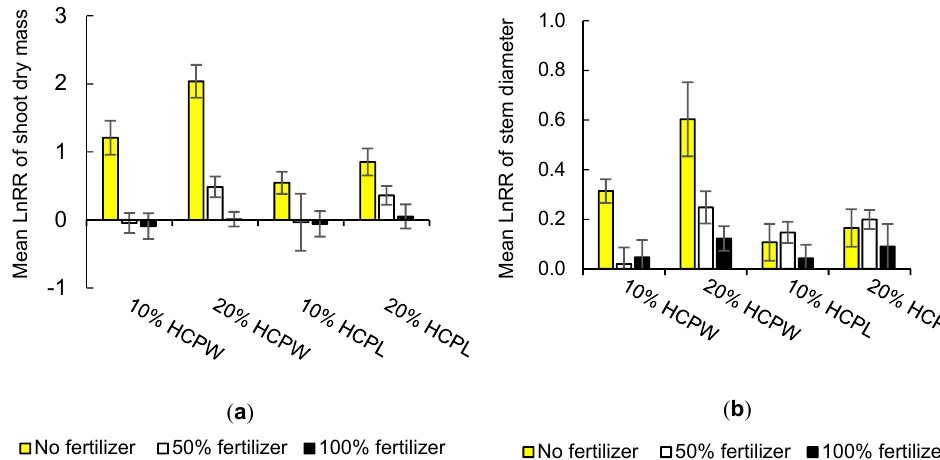
Figure 1. Mean (±95 CI, n = 10) natural logarithmic response ratios (standardized with the untreated controls at the same fertilizer level) of shoot dry mass ( a ) and stem diameter ( b ) of pine tree seedlings grown in peat mixed with 10% and 20% (v/v) hydrochar powder (HCPW) and hydrochar pellet (HCPL) in unfertilized (yellow bars), half (open bars) and full fertilized (black bars) conditions. Effects of hydrochar type and application rate were considered significant when 95% CI did not overlap with zero.